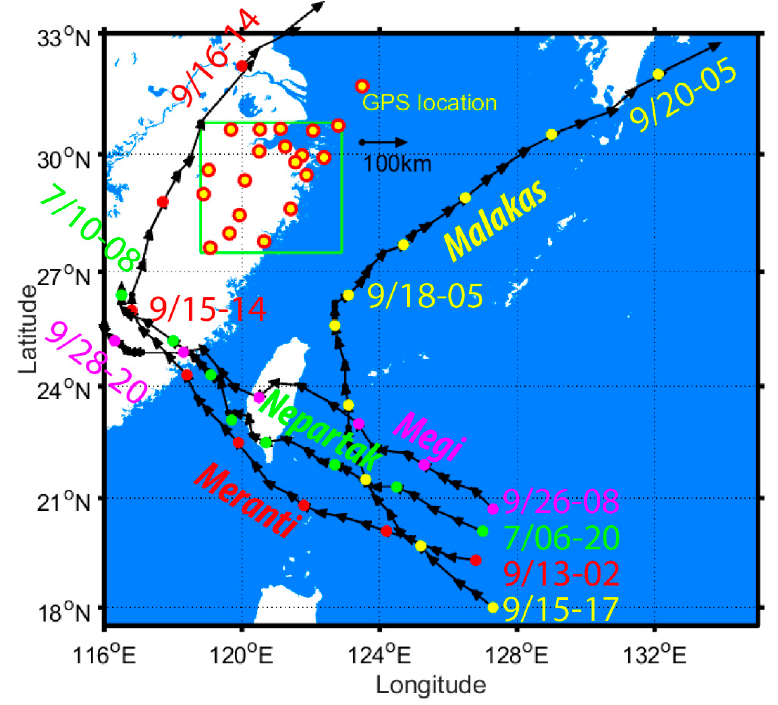
Figure 9. Route of MERANTI, NEPARTAK, MEGI, and MALAKAS typhoons every 3 h from 02:00 on 13 September to 14:00 on 16 September, 20:00 on 6 July to 08:00 on 10 July, 08:00 on 26 on September to 20:00 on 28 on September, and 17:00 on 15 September to 05:00 on 20 September, respectively, in 2016. The period between neighbouring colourful dots on the typhoon path is 12 h.